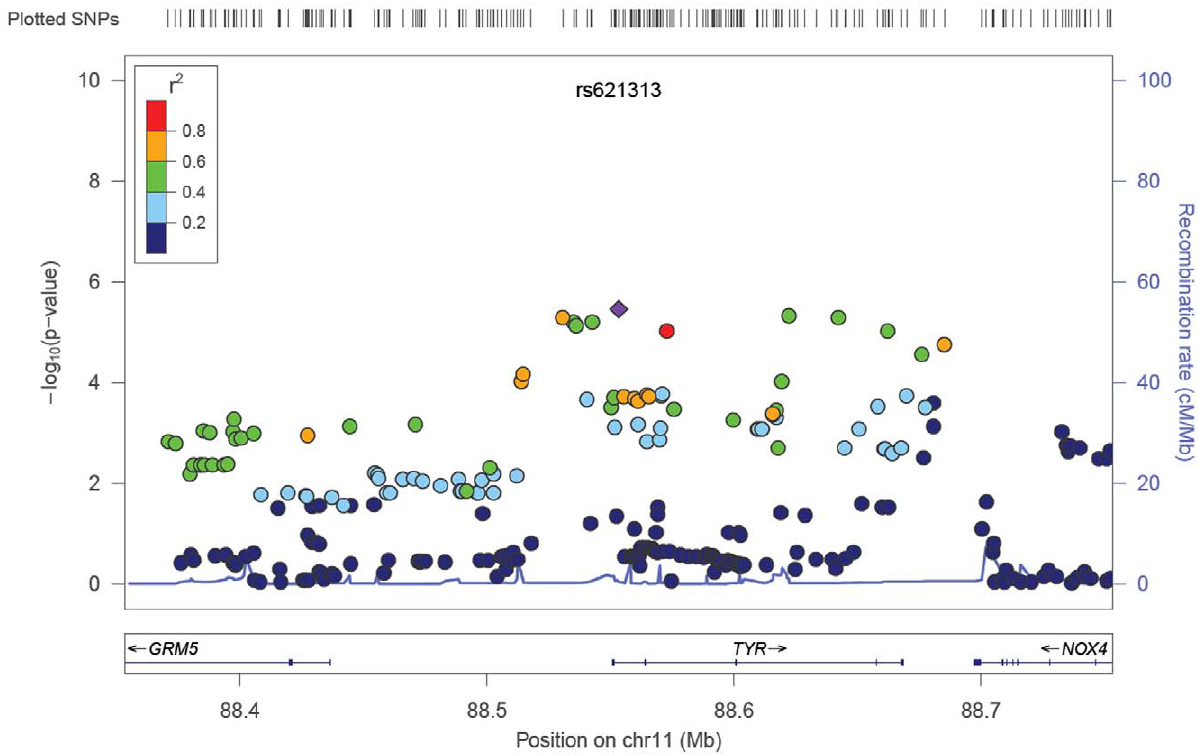
Figure 2. Regional association results for chromosome 11 SNPs in the tyrosinase precursor ( TYR ) gene. The index, associated SNP is named and shown as a purple diamond (rs621313: P =3.5 6 10 2 6 ).